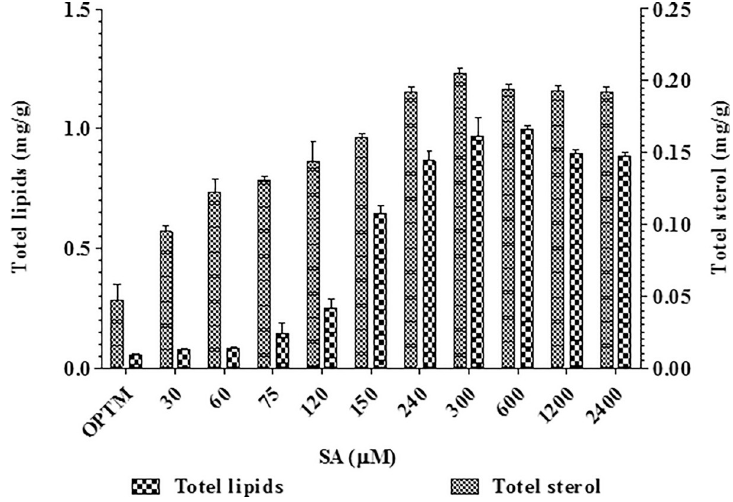
Fig 6. Effect of different concentrations of SA on total lipids and sterol by P . microspora .